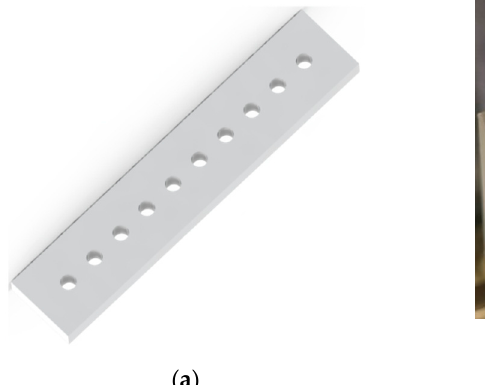
Figure 4. ( a ) Schematic of drilled holes and ( b ) actual machined holes in alumina ceramic